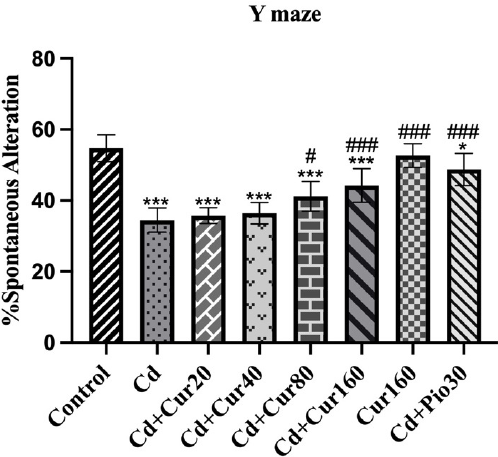
Figure 3. Effect of curcumin on Cd exposed mice depicting spatial working memory of rodents. Each column represents the mean ± SEM of 7 animals. One-way ANOVA followed by Dunnett’s post-test; * p < 0.05 and *** p < 0.001 showing significant differences between control and treatment group. # p < 0.05 and ### p < 0.001 and showing significant differences between Cd exposed group and curcumin treated groups.